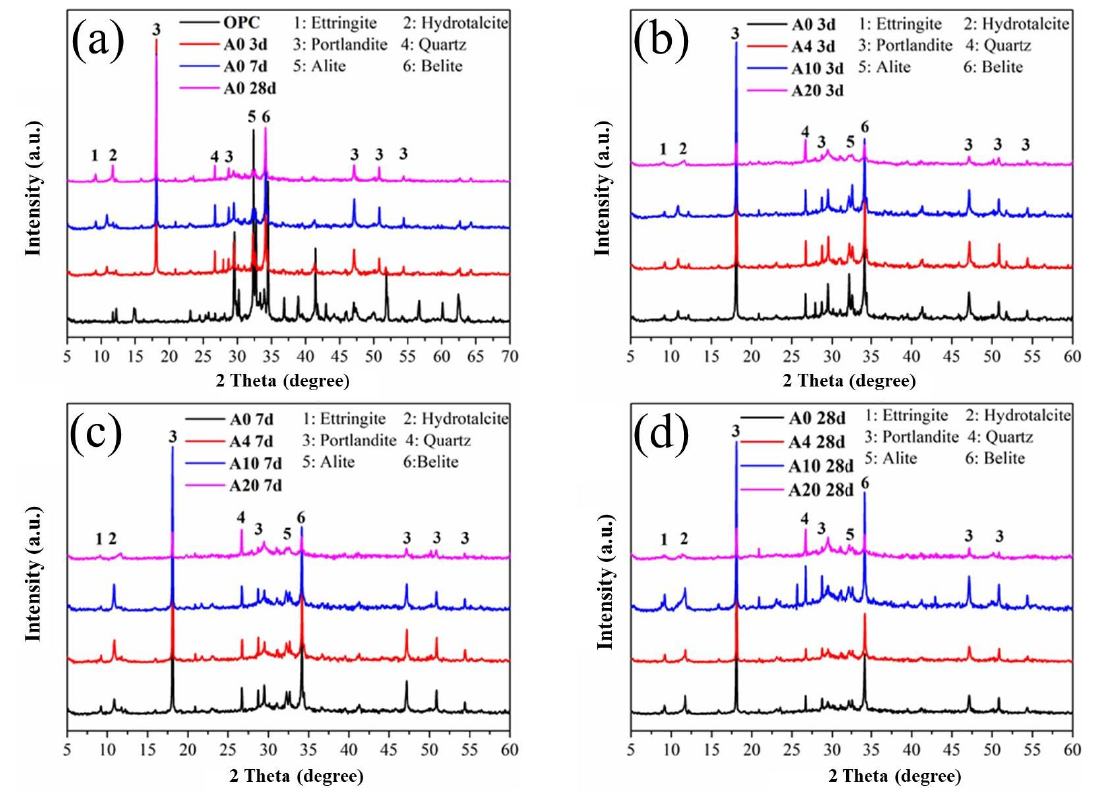
Figure 10. Phase composition analysis of calcined attapulgite cement slurry mixed with different amounts at different ages. ( a ) Control group(A0) at different age; ( b ) Different dosage at day 3; ( c ) Different dosage at day 7; ( d ) Different dosage at day 28.